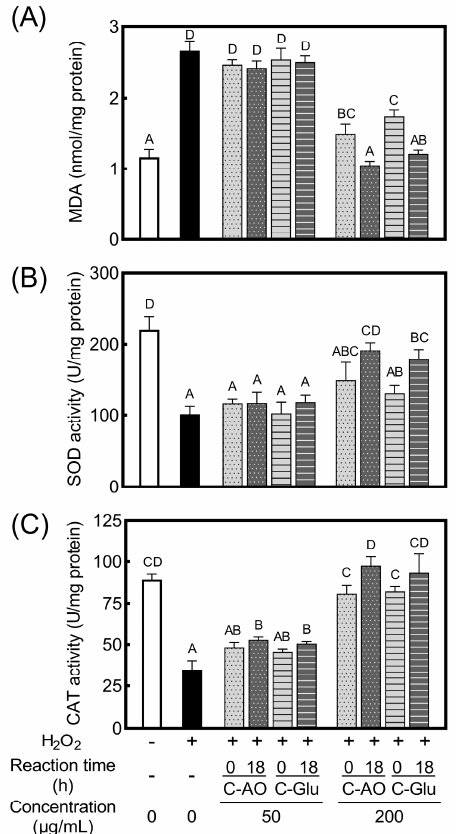
Figure 6. Effects of C − AO and C − Glu on the malondialdehyde (MDA), superoxide dismutase (SOD), and catalase (CAT) levels in RAW 264.7 cells with oxidative damage. ( A ): MDA content in RAW 264.7 cells with oxidative damage. ( B ): SOD activity in RAW 264.7 cells with oxidative damage. ( C ): CAT activity in RAW 264.7 cells with oxidative damage. All results were normalized to the protein concentration of the cell lysate ( n = 3), and bars with different letters indicate significant